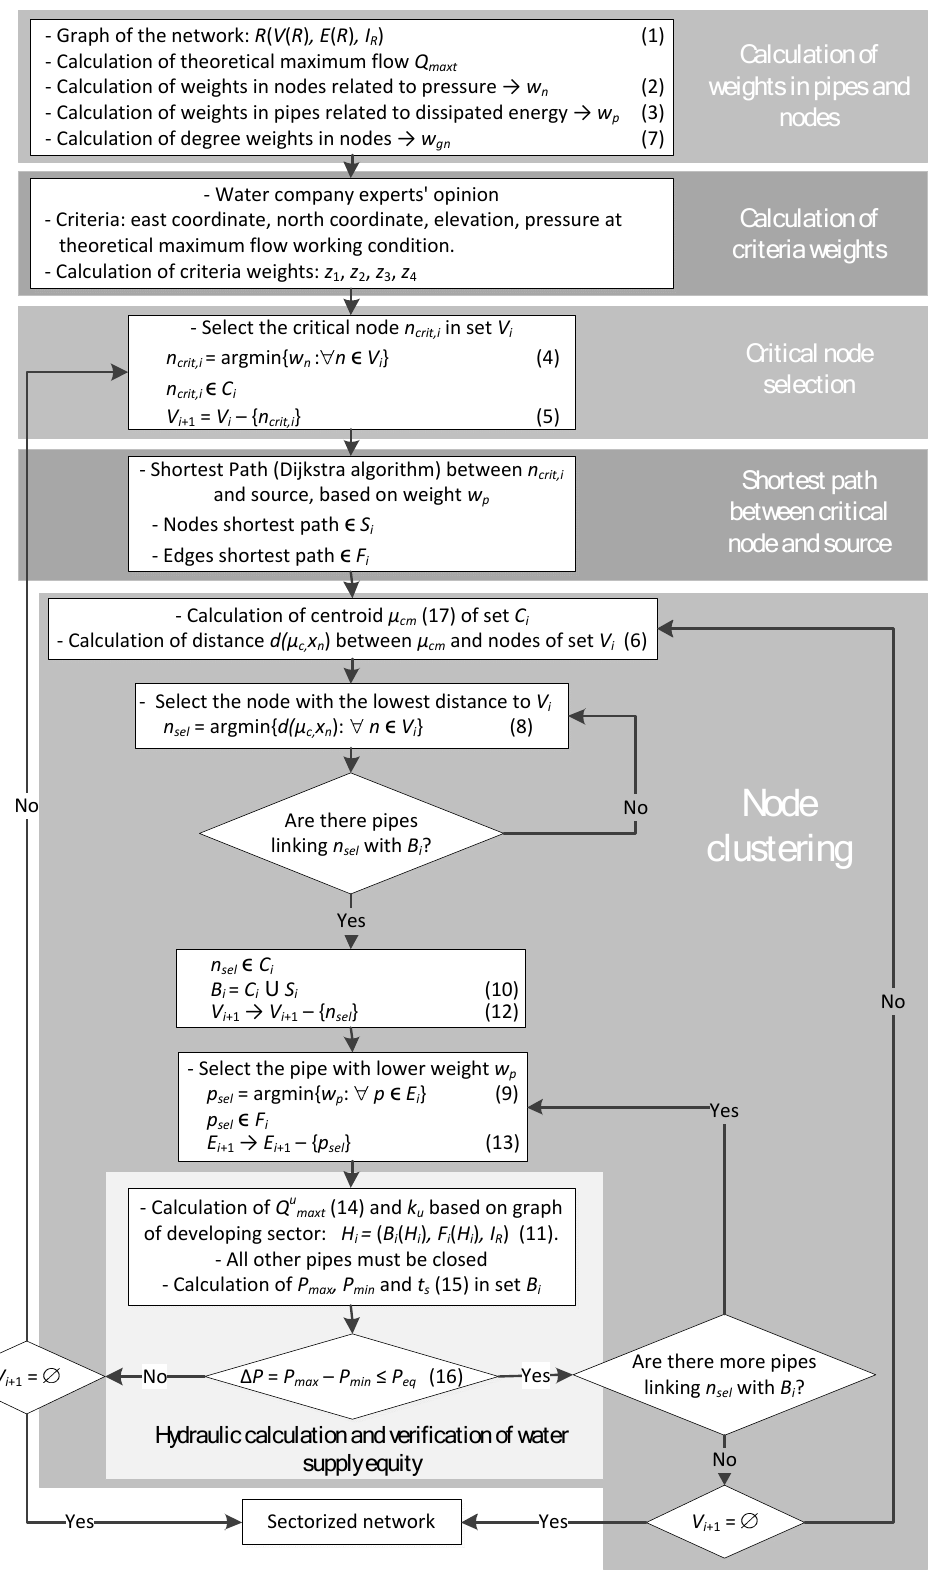
Figure 2. Flowchart, including high-level pseudocode and conceptual description, for implementation of sectors in intermittent water supply networks.